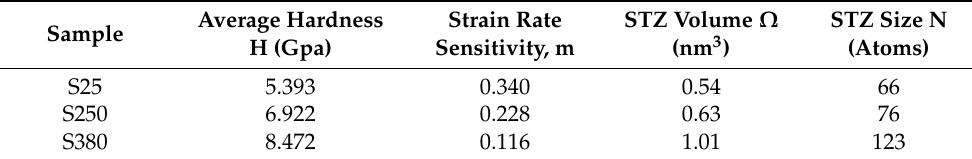
Table 1. The detailed measurement data on STZ for various samples.